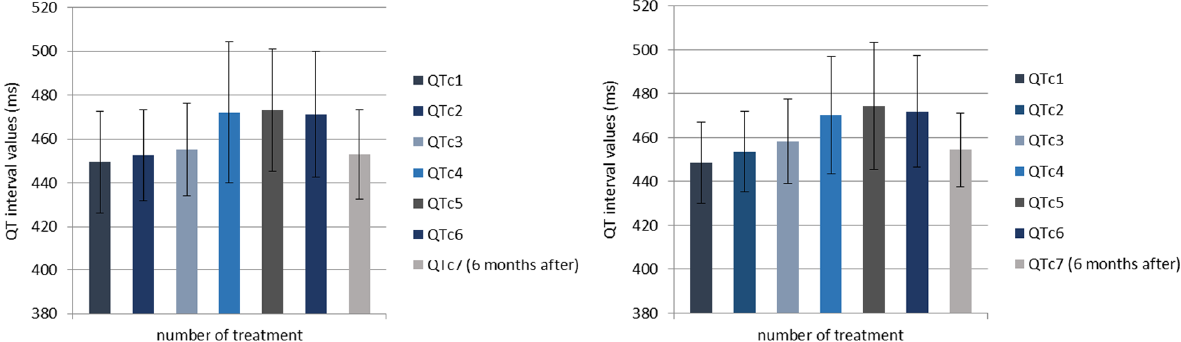
Fig. 1 QTc interval values before and 6 months after the last trastuzumab (left)/trastuzumab emtansine cycle